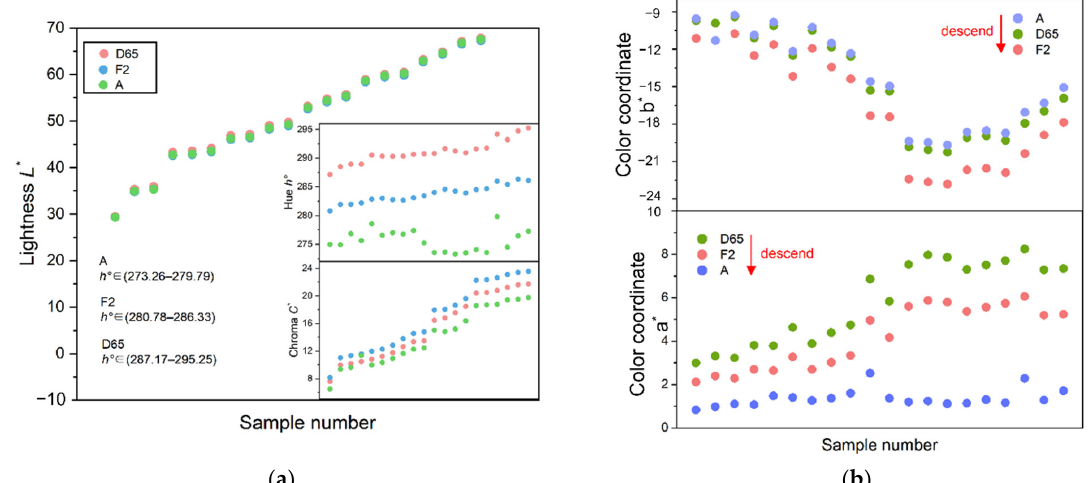
Figure 8. Comparison of color parameters under three kinds of standard light sources. ( a ) Comparison of the lightness L* , the chroma C* , and the hue angle h° ; ( b ) comparison of color coordinates a* and b*.